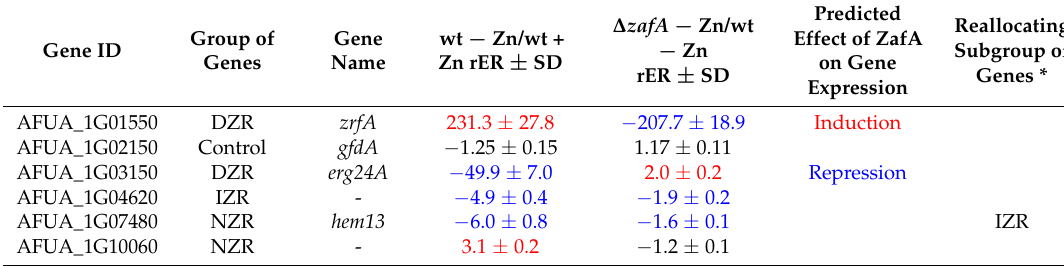
Table 2. Measurement by RT-qPCR of the expression levels of several genes of each group detected in microarrays, both in a wild-type strain grown in zinc-limiting versus zinc-replete conditions (as in Exp#1) and in a ∆ zafA strain grown under zinc-limiting conditions with respect to a wild-type strain grown in the same culture conditions (i.e., as in Exp#2). ZafA can be formally considered as an inductor or repressor of the DZR genes, as indicated. The indicated genes (*) should be reallocated into the specified group according to RT-qPCR data, provided that the genes were considered (arbitrarily) to be expressed differentially when their transcription levels changed > 1.5-fold. Expression of genes in